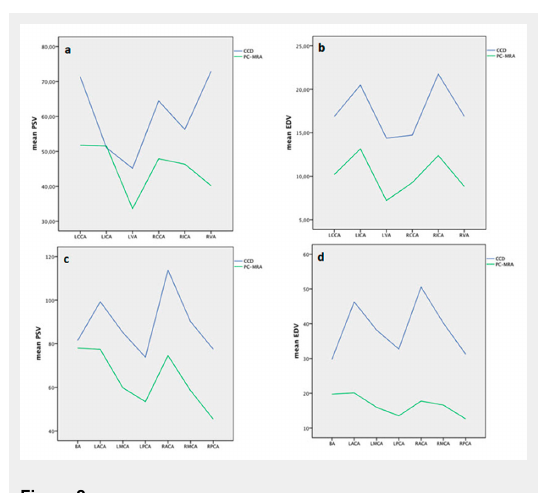
Figure 2 Mean peak systolic and end diastolic velocities of colour-coded duplex (CCD) sonography and phase contrast magnetic resonance angiography (PC-MRA) of extracranial (a,b) and intracranial (c,d) arterial segments. BA = basilar artery; LACA = left anterior cerebral artery; LCCA = left common carotid artery; LICA = left internal carotid artery; LMCA = left middle cerebral artery; LPCA = left posterior cerebral artery; LVA = left vertebral artery; RACA = right anterior cerebral artery; RCCA = right common carotid artery; RICA = right internal carotid artery; RMCA = right middle cerebral artery; RPCA = right posterior cerebral artery; RVA = right vertebral artery